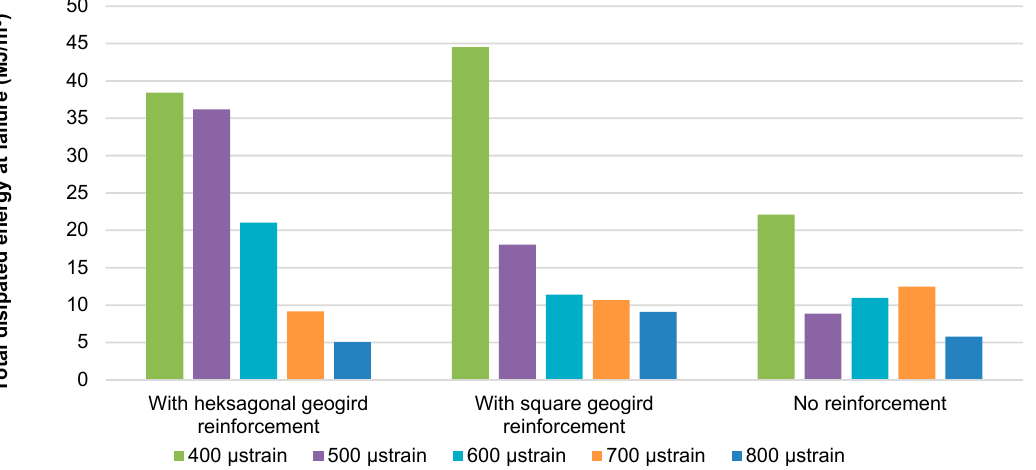
Figure 15. A comparison of the cumulative dissipated energy at failure (N f load cycles). As shown in Figure 15, at strain levels lower than 600 µ strain, the reinforced specimens dissipate significantly greater energy than the unreinforced specimens. It means that more energy is needed to cause the failure of a reinforced specimen. This effect is not